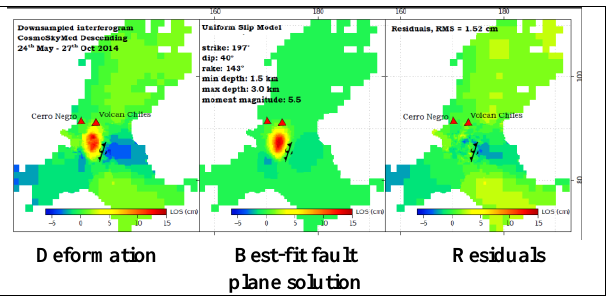
Figure 3. Ground deformations of both Chiles and Cerro Negro de Mayasquer volcanoes (Ecuador-Columbia border), courtesy of Instituto Geophysico, Ecuador.